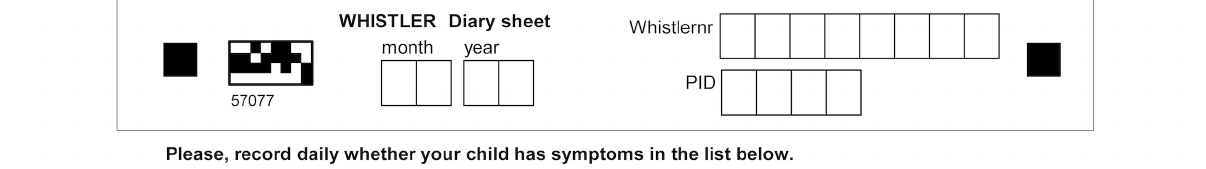
Figure 1. Paper diary sheet used in the 2013 study period. WHISTLER: Wheezing and Illnesses Study Leidsche